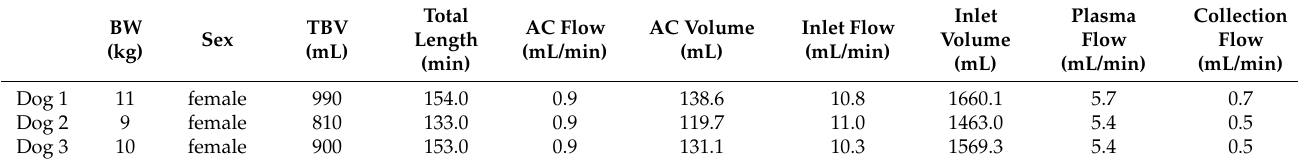
Table 1. Summary of PBMC apheresis parameters in dogs using Spectra